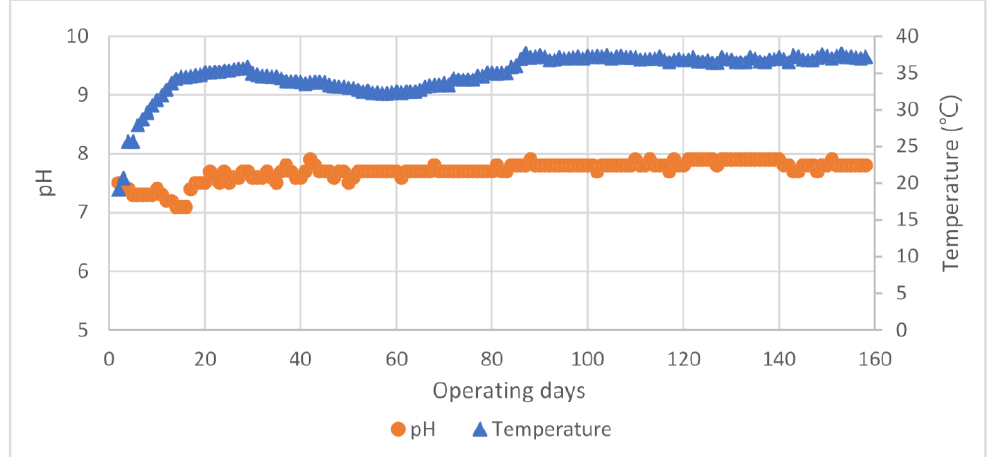
Figure 8. Change in pH and temperature during operation days.